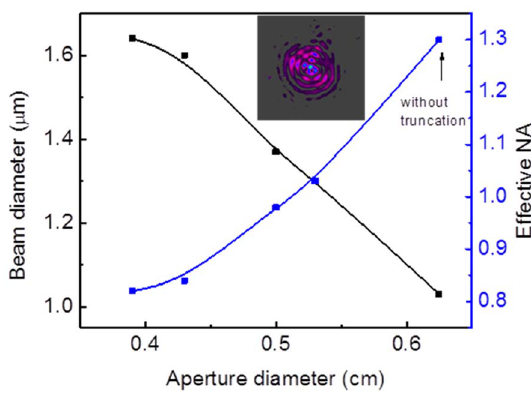
Figure 3. Measured focused beam diameter and corresponding effective NA as a function of aperture size. The inset shows a focused image of the spot obtained without an aperture.